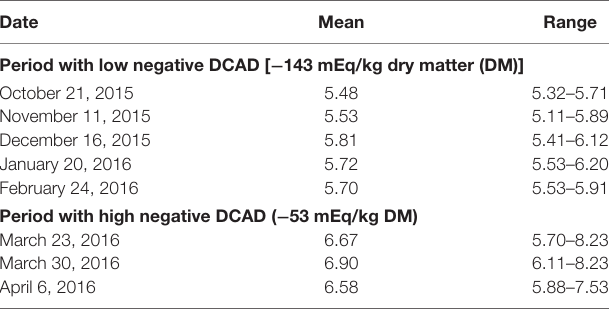
tabLe 3 | Mean and range of urine pH for prepartum dairy cows based on high and low negative dietary cation–anion difference (DCAD).